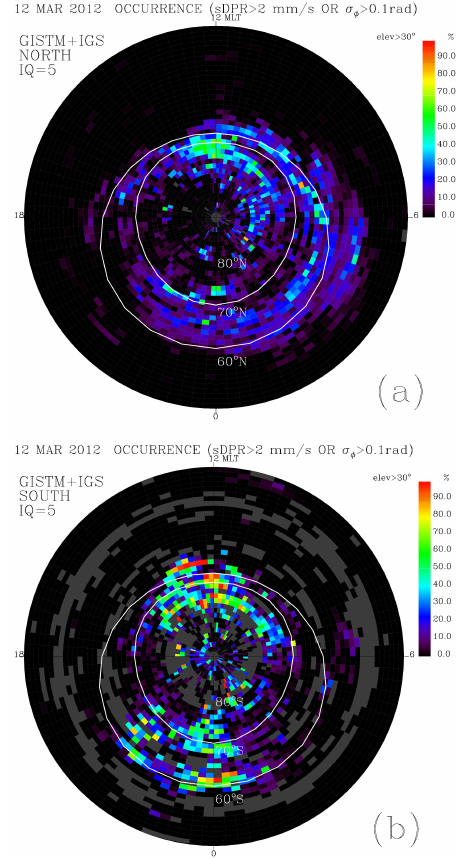
Figure 6. The composite maps of phase scintillation combining the occurrence of sDPR>2mms − 1 and σ (cid:56) >0.1rad in the (a) northern and (b) southern high latitudes on 7 March.